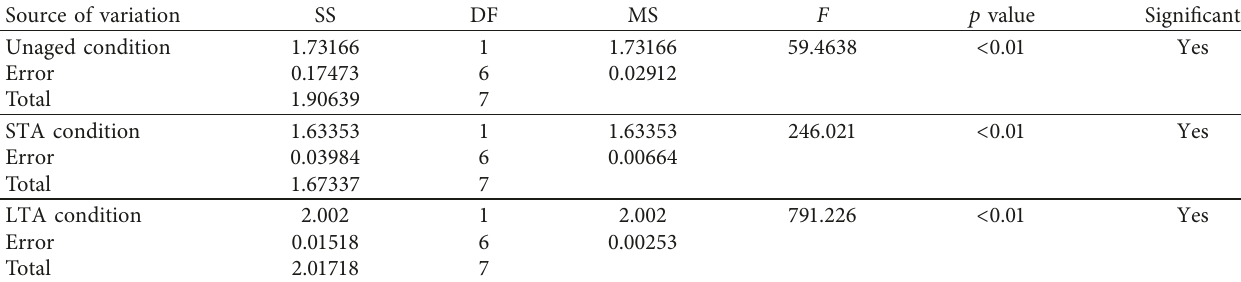
Table 9: One-way ANOVA on effects of compatibility ratio of PG-64 binder with limestone and granite aggregate. Source of variation